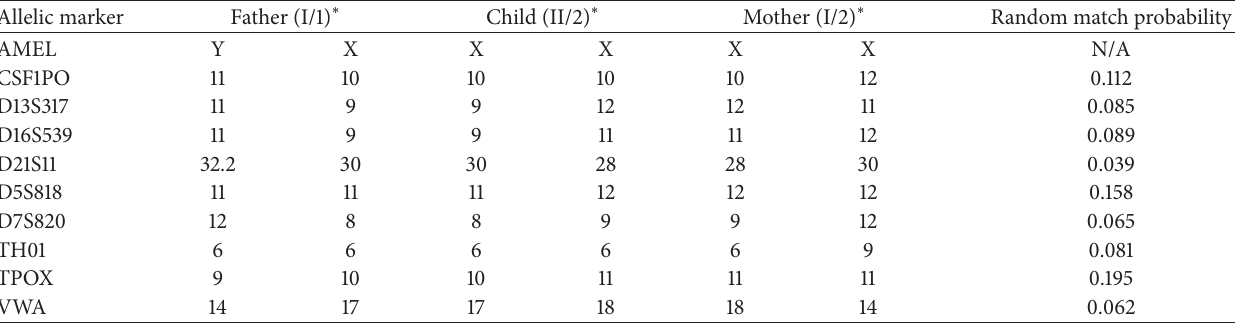
Table 2: Genotyping for a sex associated marker, amelogenin (AMEL), and 10 short tandem repeats to confirm paternity and maternity of an individual with Schnyder corneal dystrophy.